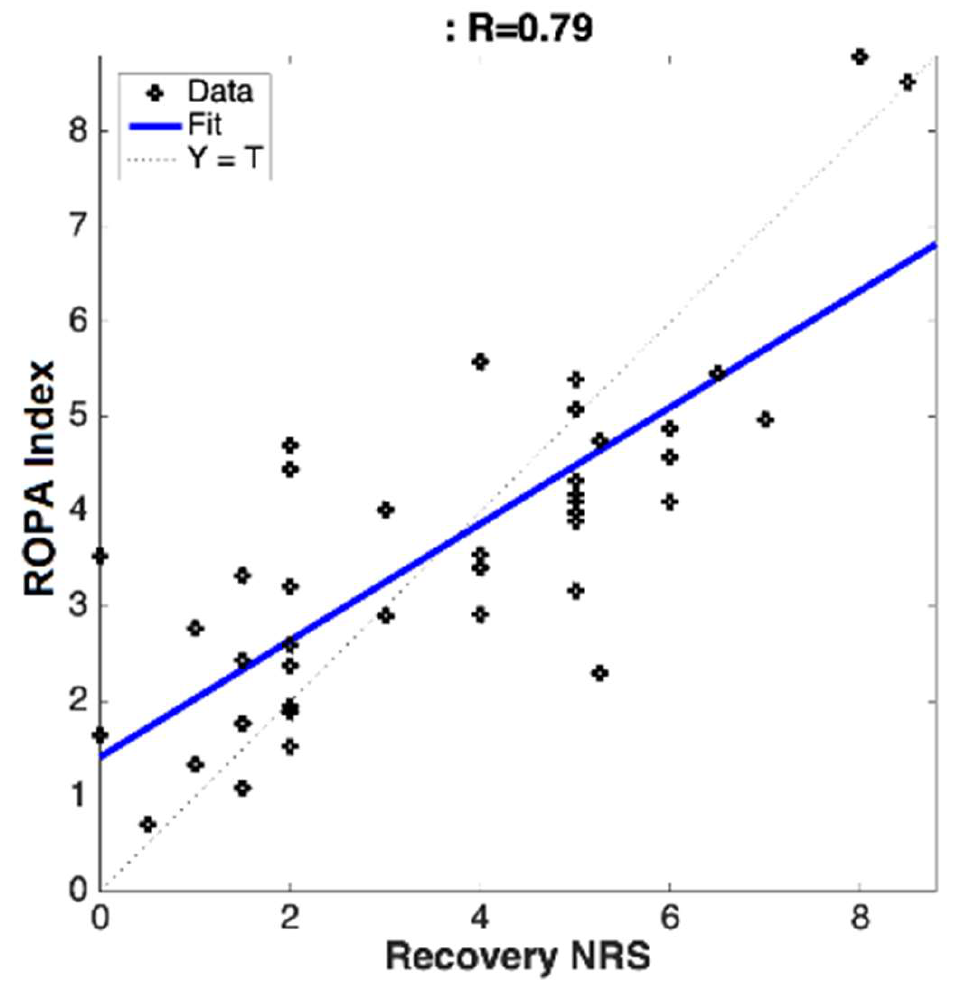
Figure 3. Linear regression between the subject-provided numeric pain rating scale (NRS) in the recovery room (after the epidural steroid injection) and the objectively measured changes in the physiological parameters responding to pain (ROPA Index).